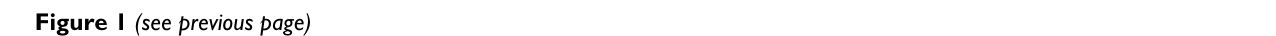
Rather than using a sister chromatid for repair (for example, if the break has not occurred during or after S phase), repair is effected (dashed line) using the other copy of chromosome 5 as a template. This causes the distal long arms of the two chro- mosome 5 s, including the APC mutation, to become genetically identical and hence LOH at APC occurs.